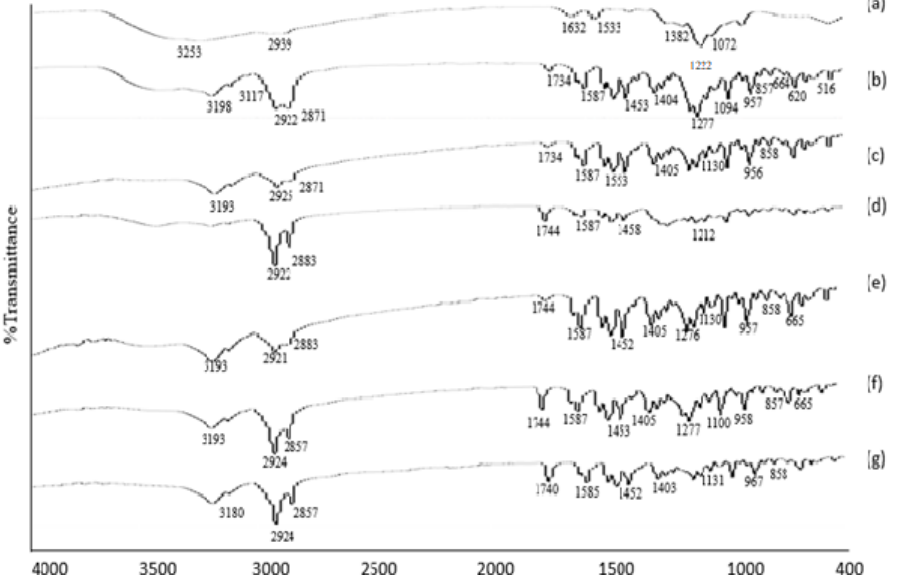
Figure 1. FTIR spectra of (a) VRZNA, (b) VRZNB, (c) VRZNC, (d) VRZND, (e) VRZNE, (f) VRZNF, and (g) VRZNG.